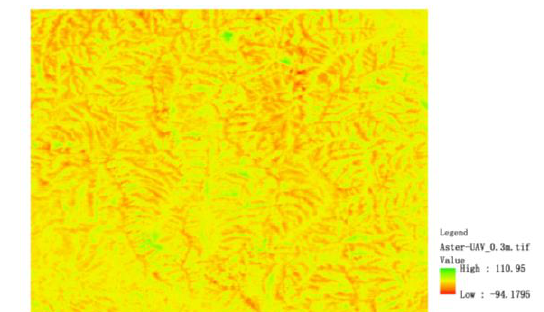
Figure 13. The spatial distribution of the errors derived from the ASTER DEM and the UAV DEM (0.3m